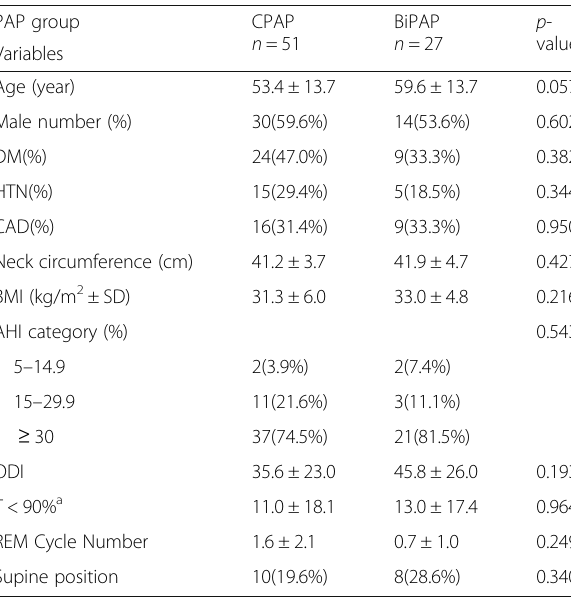
Table 3 Result of Logistic Regression Analysis for Device Therapy